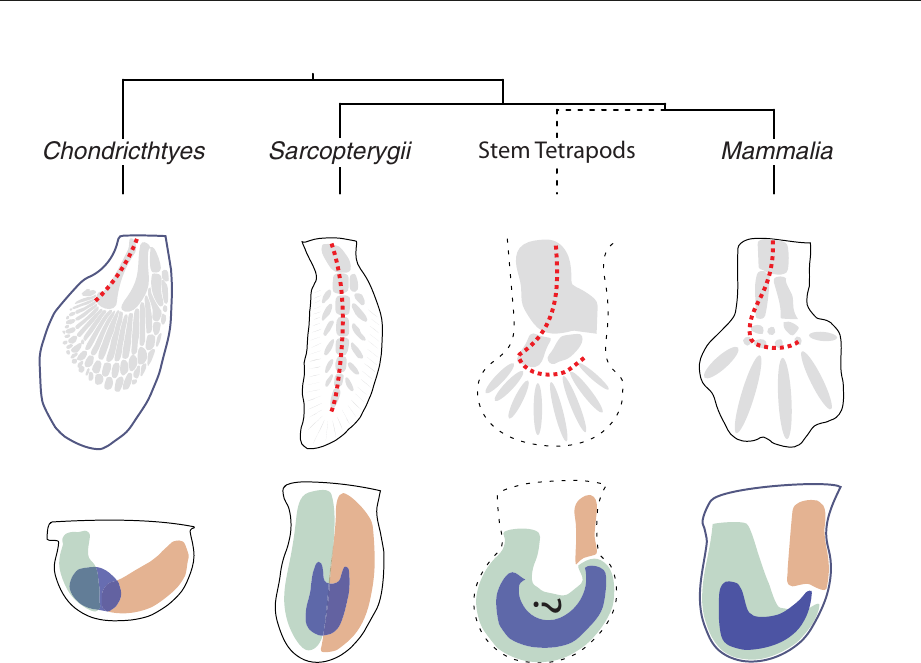
Fig. 8 Fish and tetrapod Grem1 expression patterns recapitulate molecular and morphological hallmarks of the fi n-to-limb transition. Upper panels: schematics of the endochondral skeletons (shaded grey) with the appendage (metapterygial) axis indicated by a red dotted line. Lower panels: schematized spatial expression of Grem1 (blue), posterior genes (green: e.g. 5 ’ Hoxd and Hand2 genes) and anterior genes (orange: e.g. Alx4 and Pax9 genes). The expression of posterior genes expands distal-anterior and anterior genes remain more proximally restricted during tetrapod limb bud